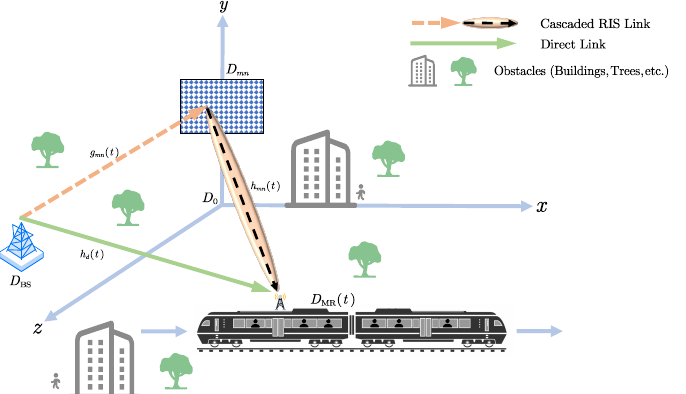
Figure 1. An RIS-assisted HSC system. Note that the obstacles cause NLoS components for direct and cascaded